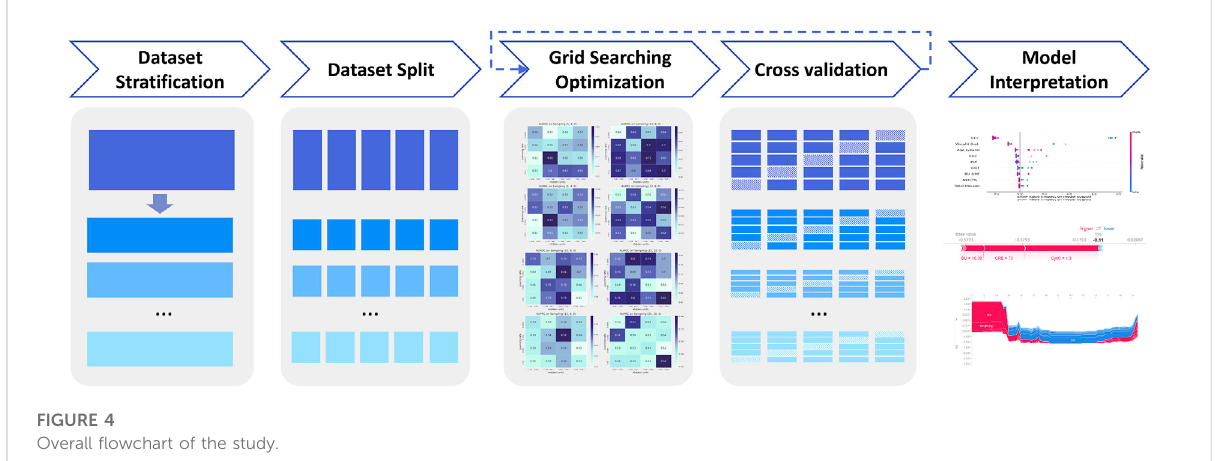
FIGURE 4 Overall fl owchart of the